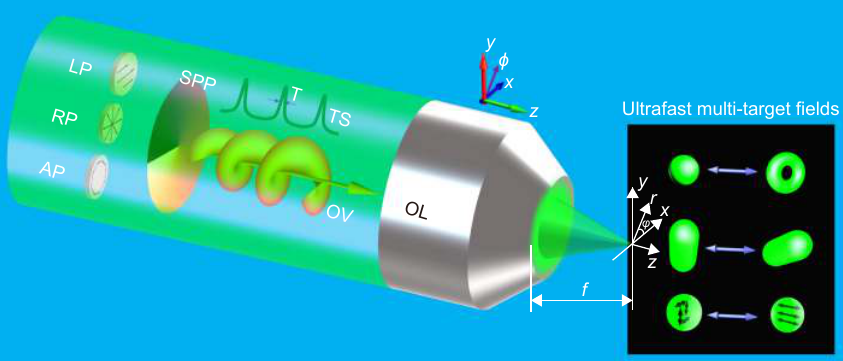
Fig. 1 | The conceptual schematic to yield ultrafast multi-target light fields in a single high NA objective focusing configuration. Right in- set in black area represents the light fields with three sorts of patterned conversions as time elapses. Therein, the first row denotes the bright- dark alternative optical field especially for the radially polarized beam illumination; the second row shows periodic rotational light field actuated by arbitrary polarizations; the third row stands for reciprocal conversion between different polarized field components. LP: linear polarization; RP: ra- dial polarization; AP: azimuthal polarization; SPP: spiral phase plate; TS: time sequence; OV: optical vortex; OL: objective